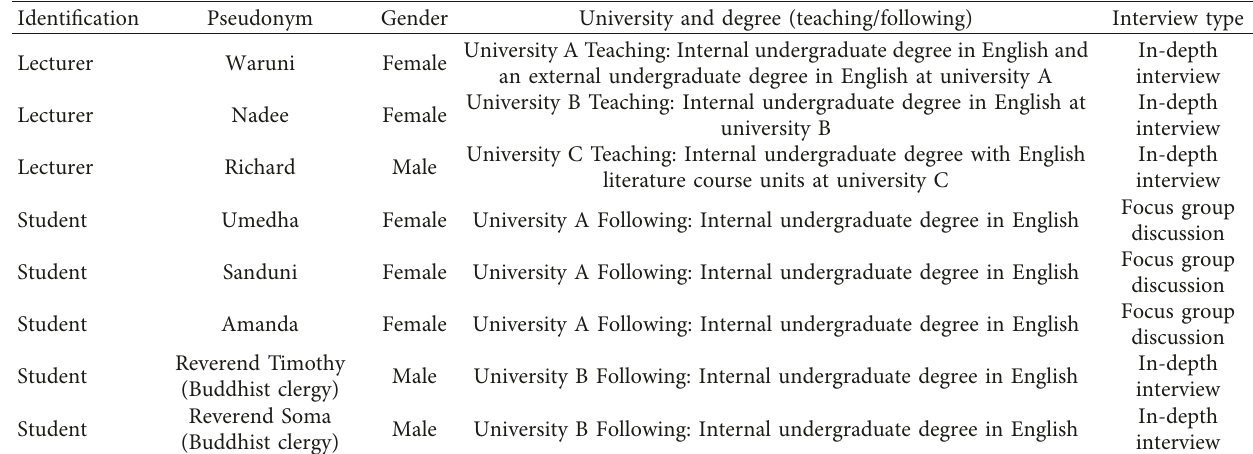
Table 1: Information on research participants.